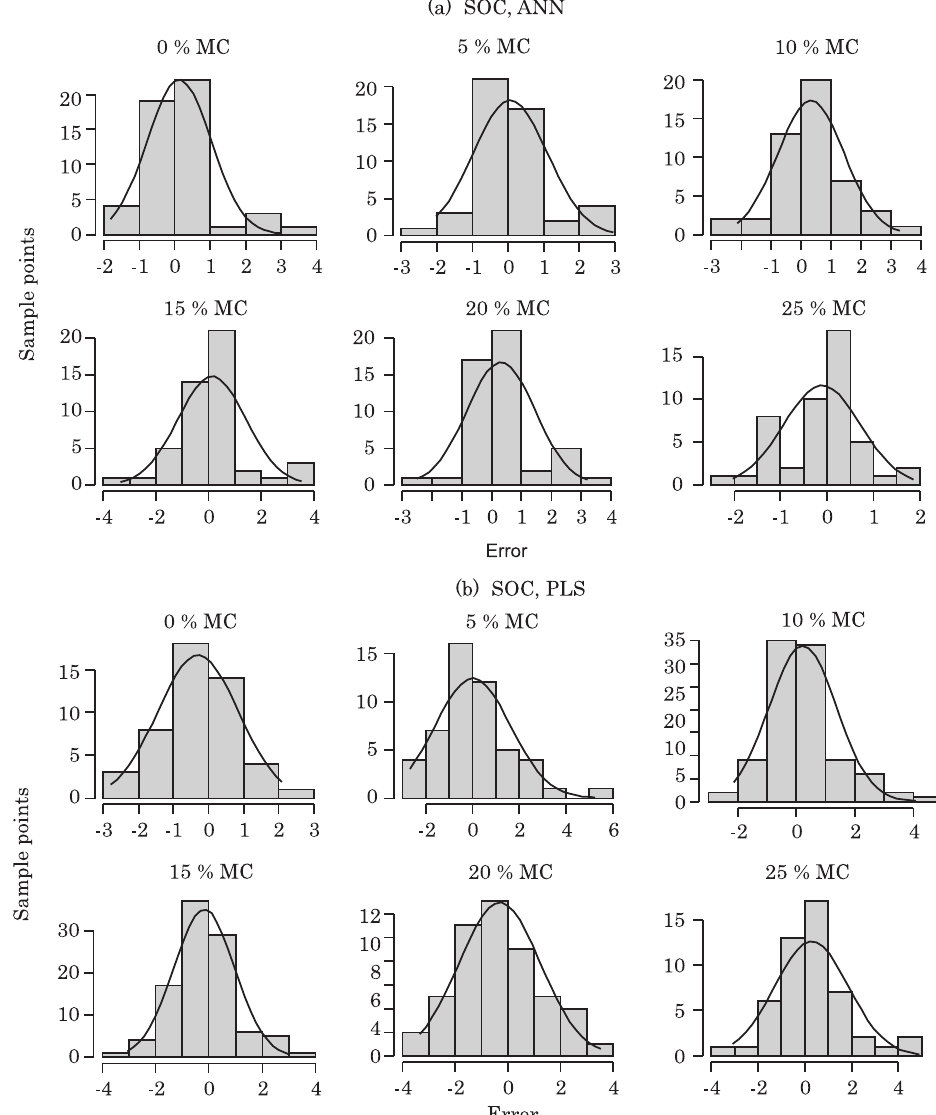
Figure 2. Histogram of normal distribution of error for the artificial neural network (ANN) predictions (a) and partial least squares (PLS) predictions (b) of soil organic carbon